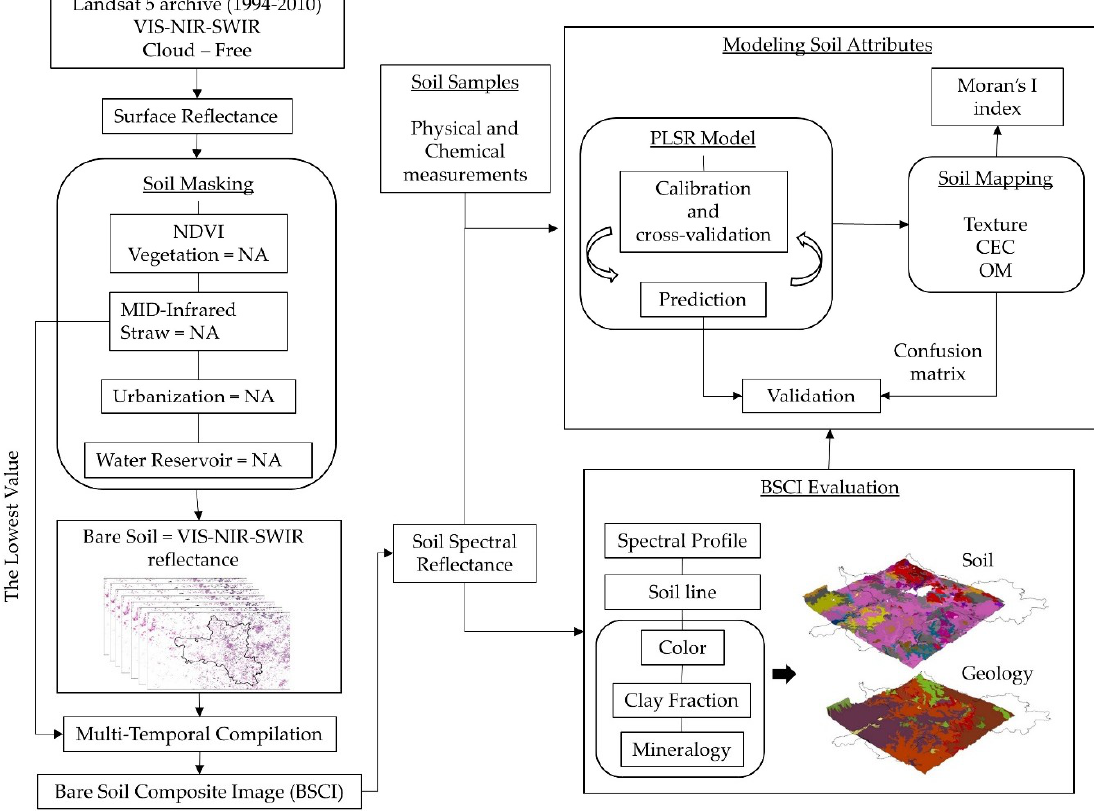
Figure 1. Flowchart of the method applied to obtain a multi-temporal bare soil image and predict soil clay content, Cation Exchange Capacity (CEC), and Organic Matter (OM) maps.